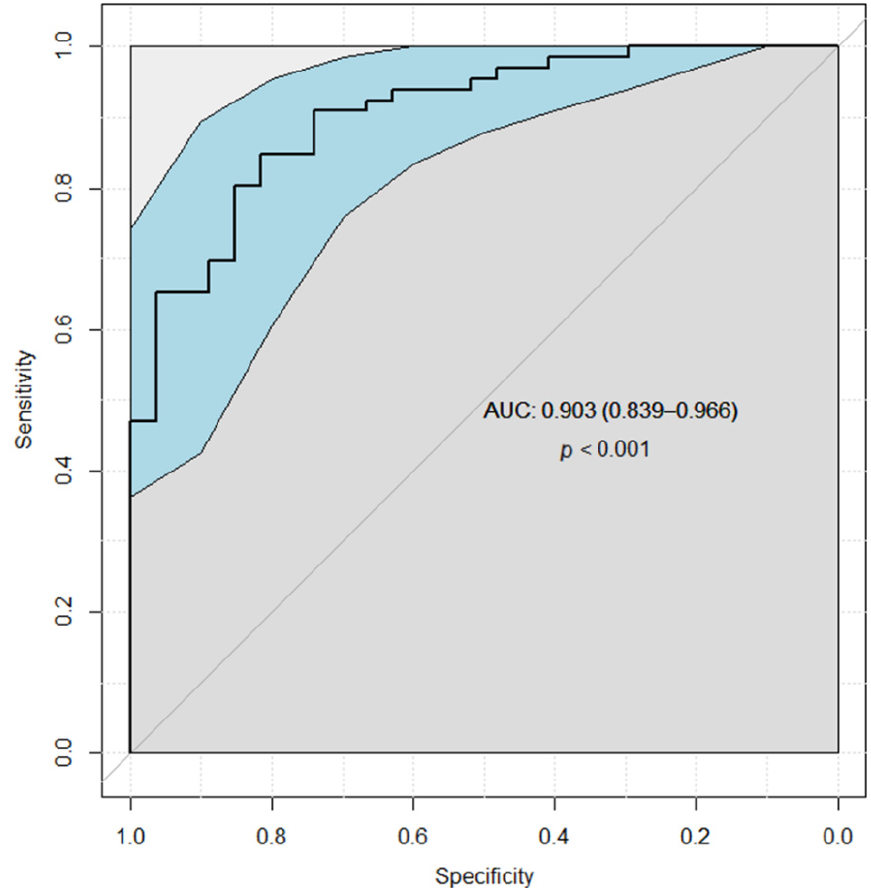
Figure 8. ROC analysis of predicting clinically significant AKI after radical nephrectomy. Abbreviations: AUC—area under the curve.